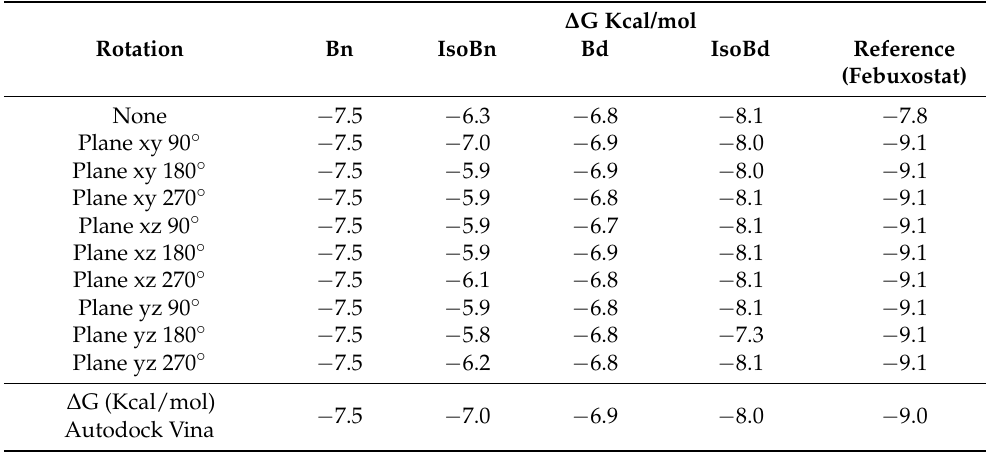
Table 3. ∆ G of compounds under study and reference considering geometry of ligands founded on shape theory and one calculated by expert software. ∆ G Kcal/mol Rotation Bn IsoBn Bd